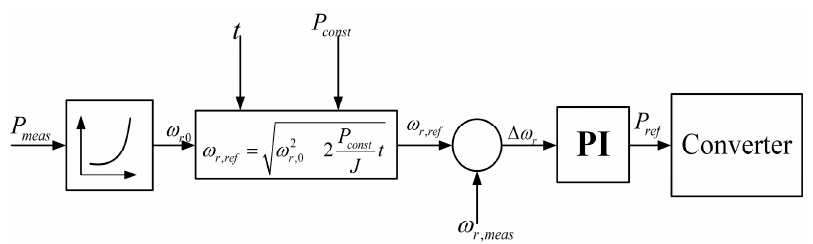
Figure 10. Fast power reserve control.